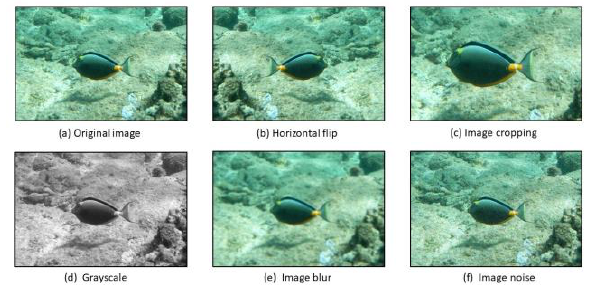
Figure 3 . Some examples of the data augmentation step: (a) original image, (b) horizontal flip, (c) image cropping, (d) grayscale, (e) image blur up to 10px, (f) image noise up to 10% of pixels